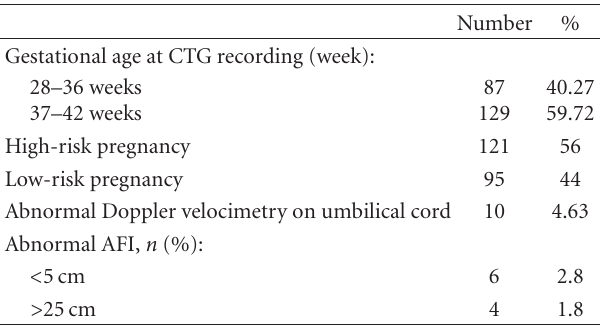
Table 1: Patients’ characteristics. Table 2: Babies’